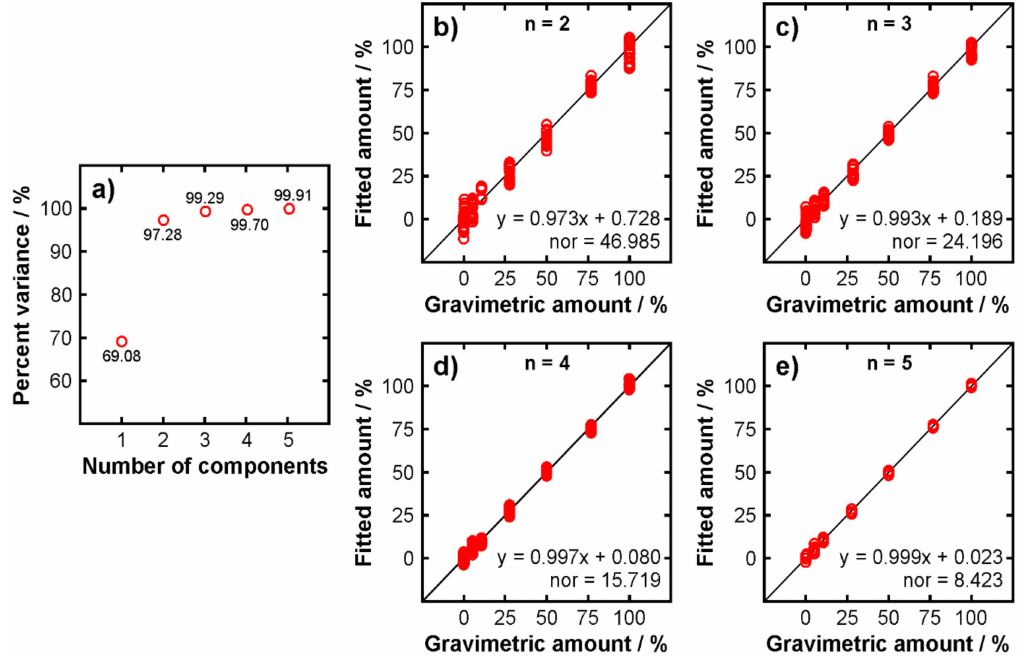
Figure 7. Partial least-squares regression (PLSR) results of the blends. ( a ) Cumulative variance